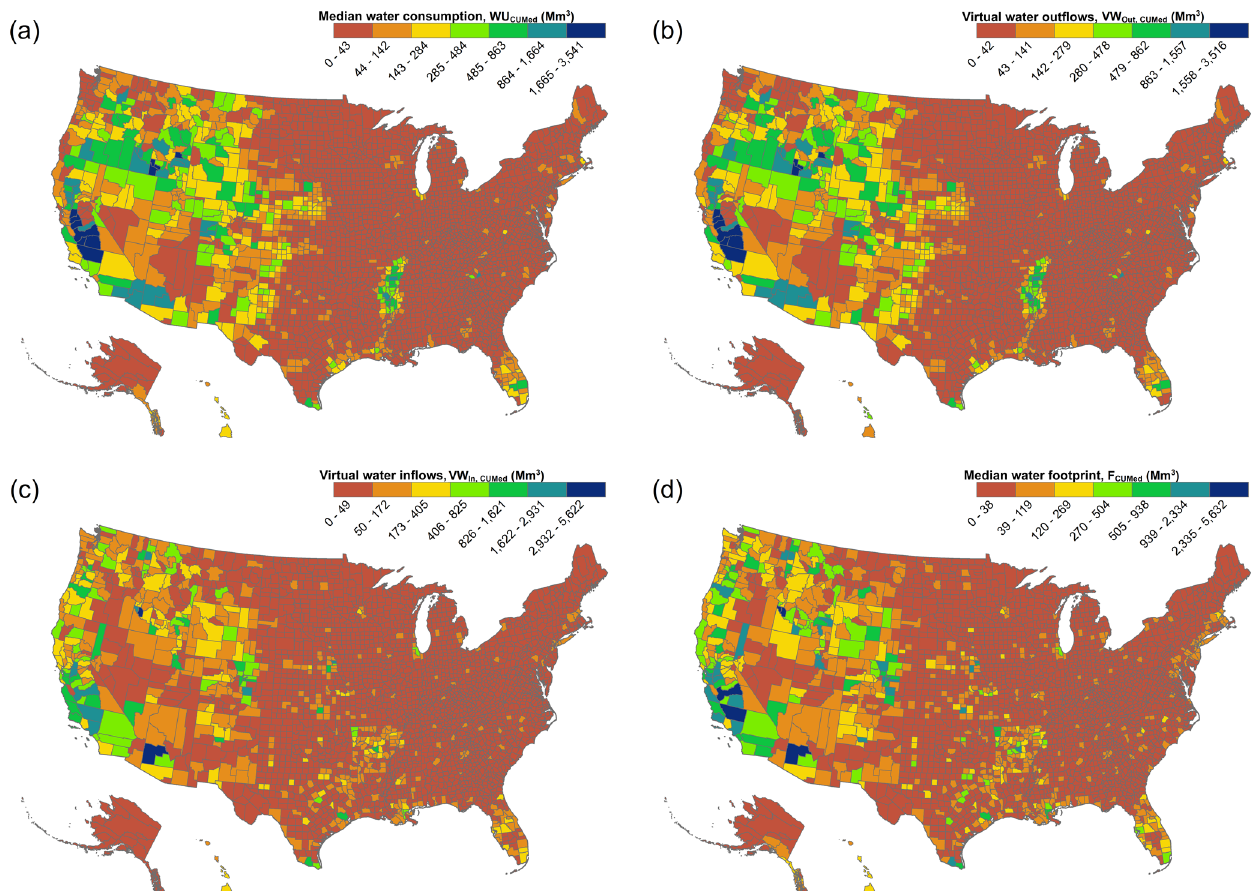
Figure 1. (a) Median county-level blue water consumption in the US. (b) Blue virtual water outflows from US are concentrated in the western United States, particularly where irrigated agriculture is located, in addition to the High Plains, Mississippi Embayment, and southern Florida. (c) Blue virtual water inflows are concentrated in western US cities, western US agricultural counties, metropolitan regions in the eastern US, and in particular where a city also serves as a regional distribution center or has prominent food processing industry (Little Rock and northwestern Arkansas, Chicago, and Houston). (d) Annual withdrawal-based (CU Med ) blue water footprint, F CUMed (Mm 3 ), for US